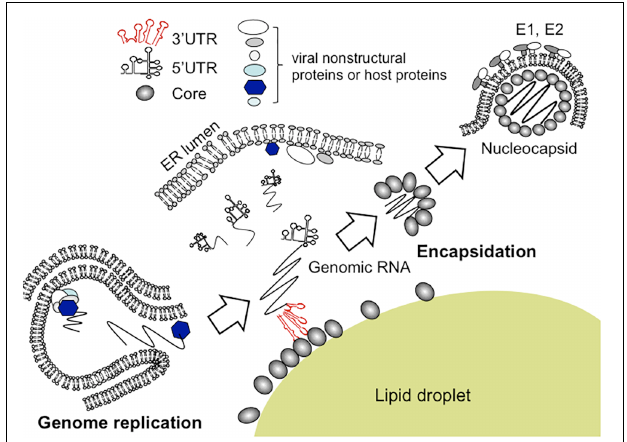
FIGURE 2 | Proposed model for encapsidation of HCV genome. Newly synthesized HCV genomic RNA is released from membrane vesicles containing the replication complex ( lower left ). It may be likely that the viral genome bound to NS5A is recruited to the surface of lipid droplets, enabling its interaction with Core. For nucleocapsid formation, the 3 (cid:48) UTR of the HCV genome acts as a cis -acting element for RNA packaging. Within the 3 (cid:48) UTR region, the loop sequences of stem-loop structures appear to be essential for HCV